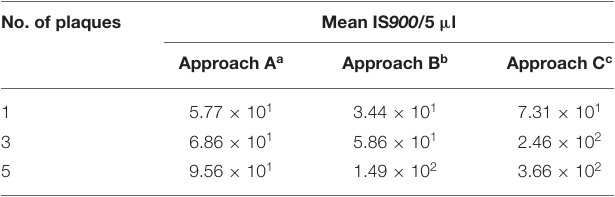
TABLE 4 | Performance of different plaque PCR approaches in detecting the IS 900 signature sequence in DNA extracted from various numbers of plaques. No. of